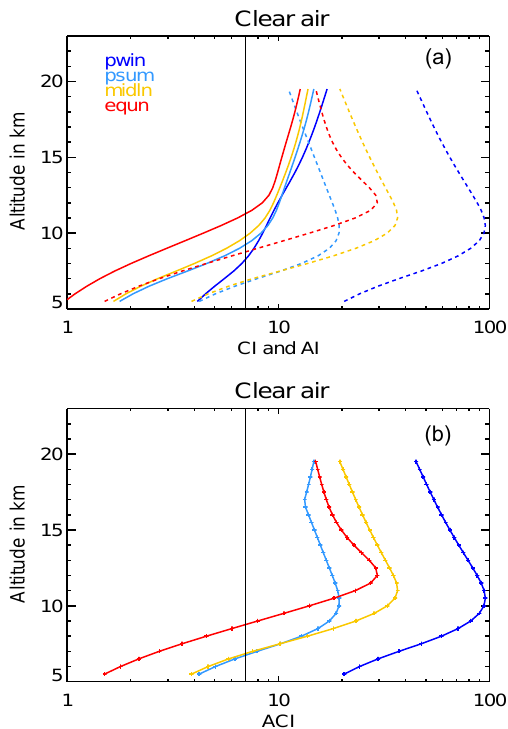
Figure A3. Simulated profiles for clear air in polar winter (dark blue), summer (light blue), midlatitude (yellow), and equatorial (red) atmosphere. (a) CI (solid lines) and AI (dashed lines). (b) ACI.